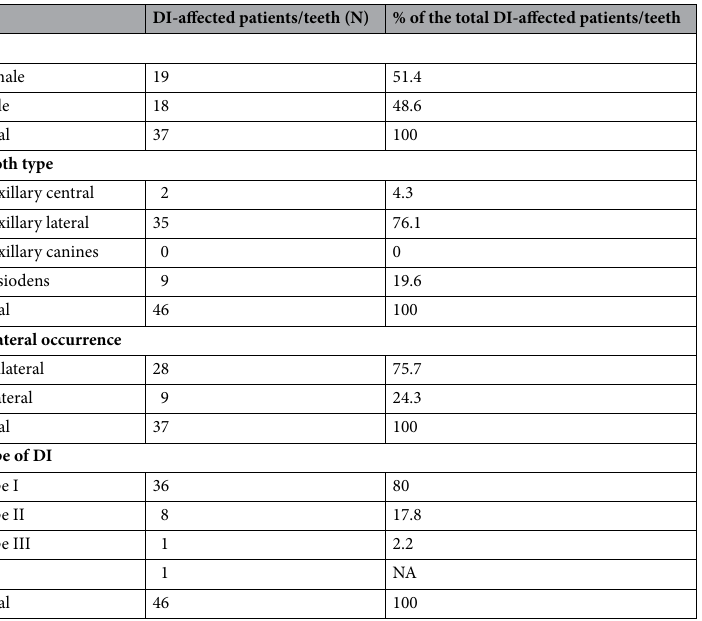
Table 2. Distribution of DI-affected patients/teeth according to sex, tooth type, bilateral occurrence, and Oehlers classification. NA Not